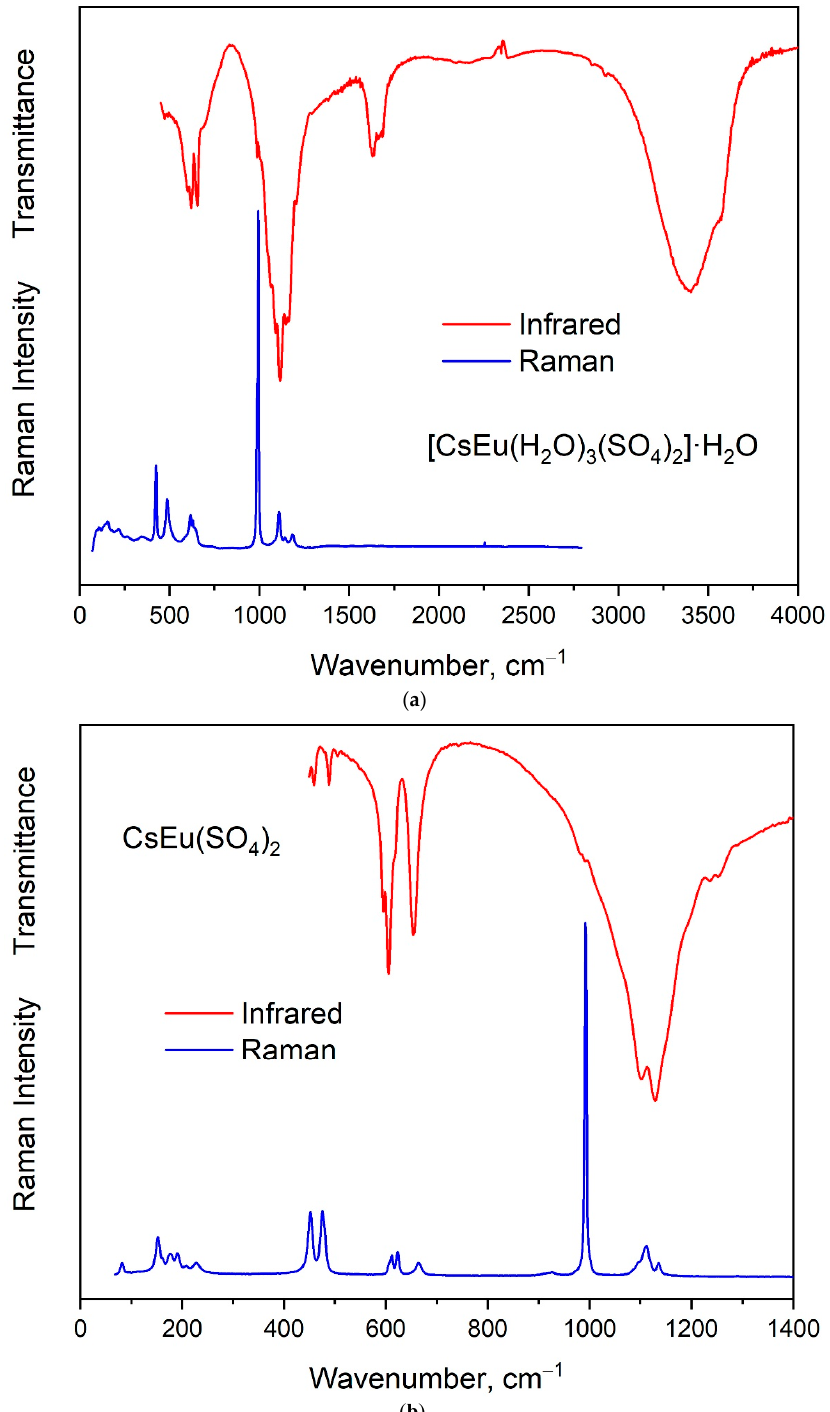
Figure 5. Infrared and Raman spectra of ( a ) [CsEu(H 2 O) 3 (SO 4 ) 2 ]·H 2 O and ( b ) CsEu(SO 4 ) 2 .